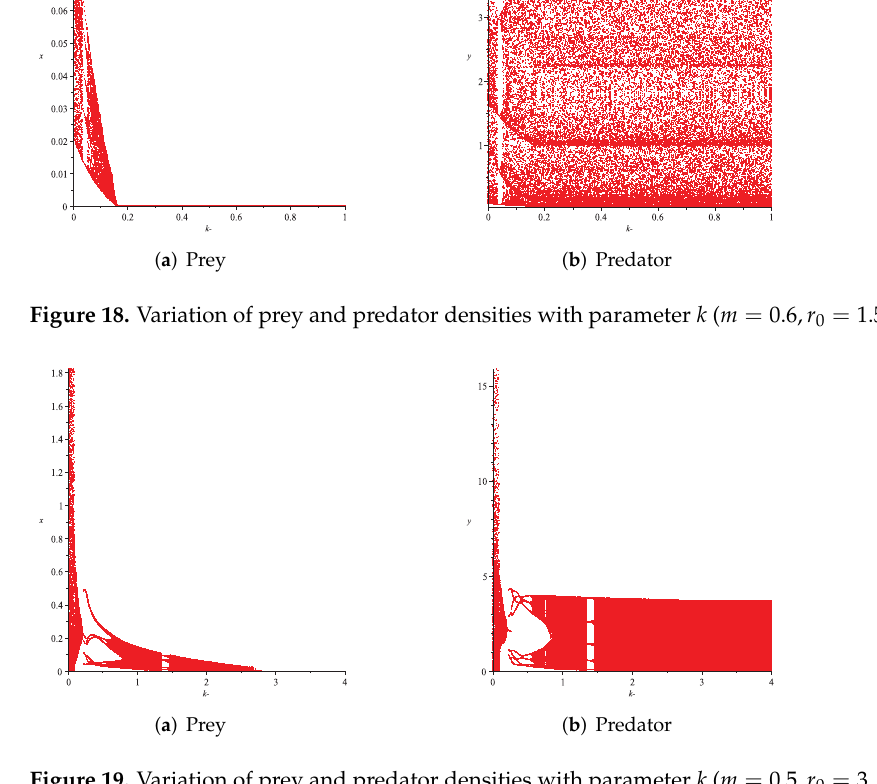
Figure 19. Variation of prey and predator densities with parameter k ( m = 0.5, r 0 = 3, h =